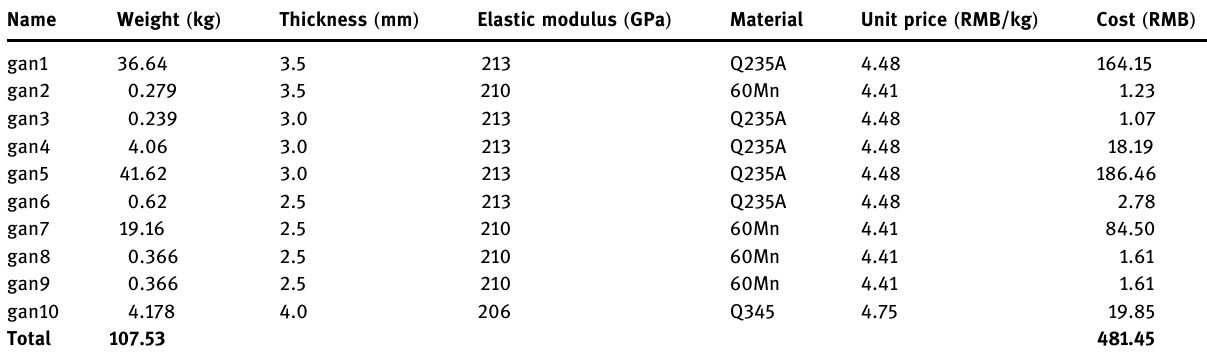
Table 9: Parameters of the fi nal optimization scheme